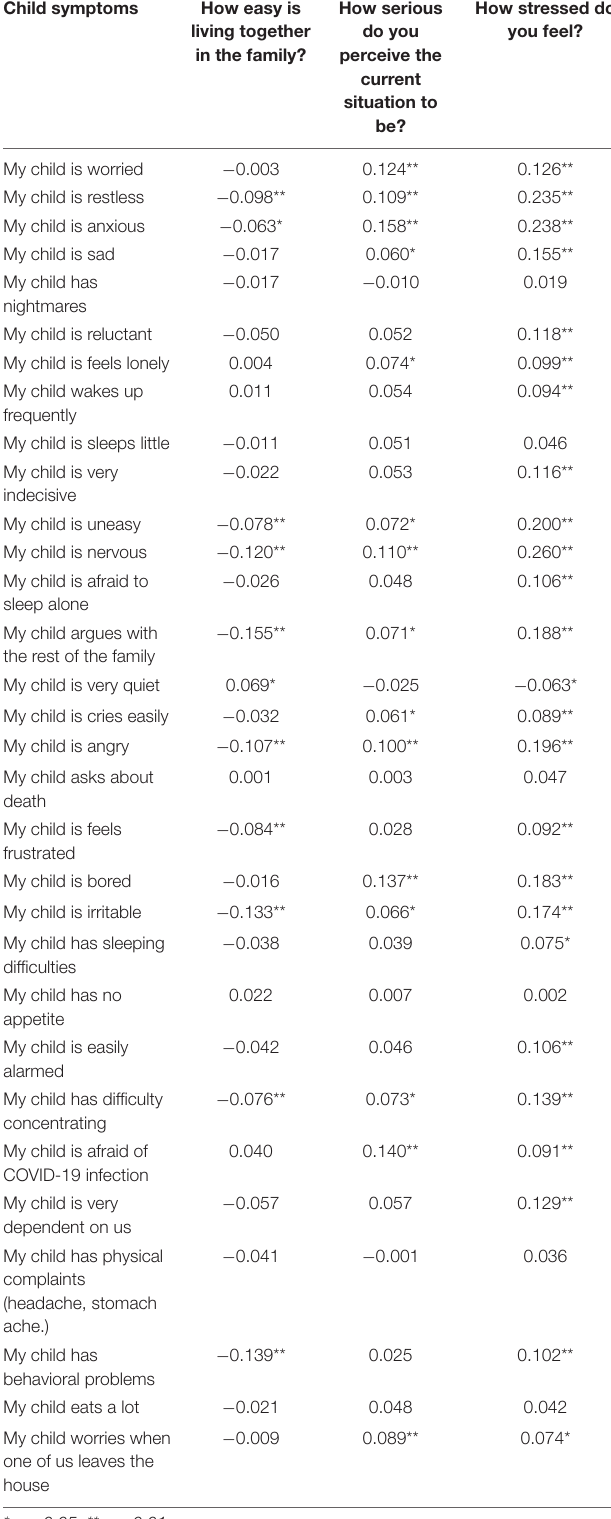
TABLE 3 | Spearman correlations between primary caregivers’ perception of emotional and behavioral effects on their children and their perception of the situation due to